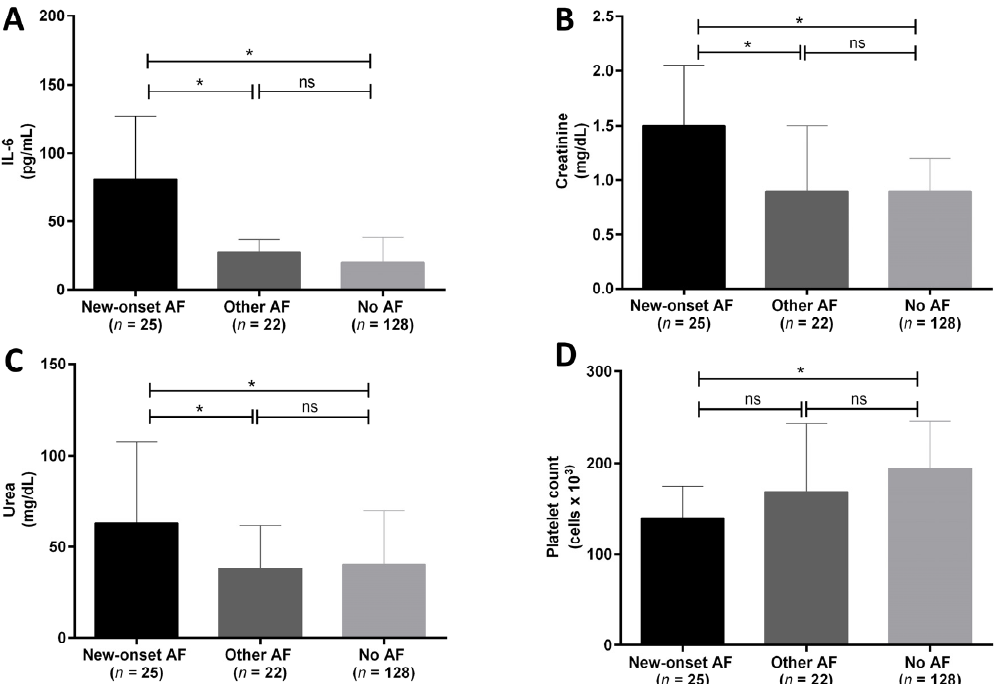
Figure 1. ( A – D ). Between-groups analysis of IL-6 ( A ), creatinine ( B ), urea ( C ) levels, and platelet count ( D ), after ANOVA results (see Table 2) in hospitalized COVID-19 patients with new-onset atrial fibrillation (new-onset AF, n = 25, black column), with other forms of AF (other AF, n = 22, dark grey column) and without AF (no AF, n = 128, light grey column). Data are expressed as median ± interquartile range. * = p < 0.5; ns = not significant.